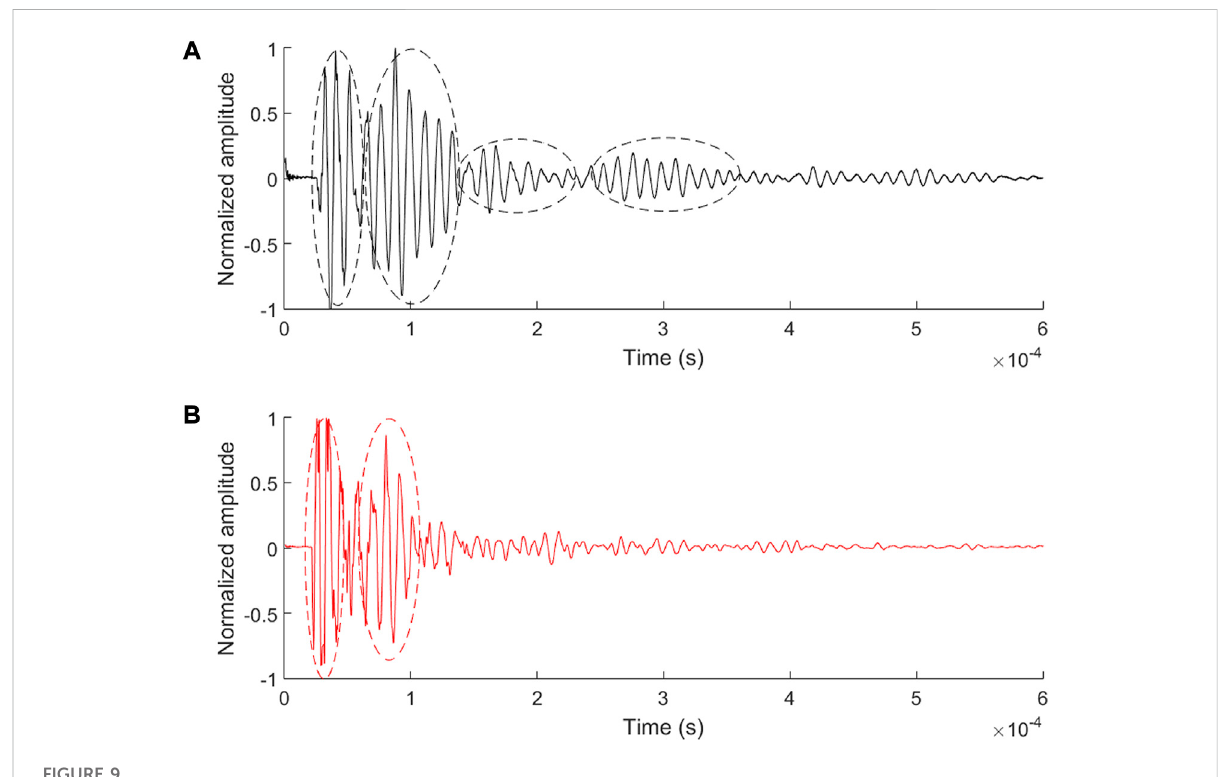
FIGURE 9 Waveforms of the defect sample (A) with MSL (B) without MSL.